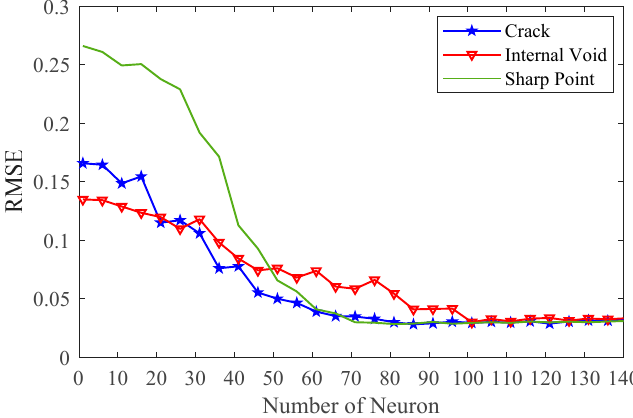
Figure 6. Considering the suitable number of neurons for the three different RF signals.